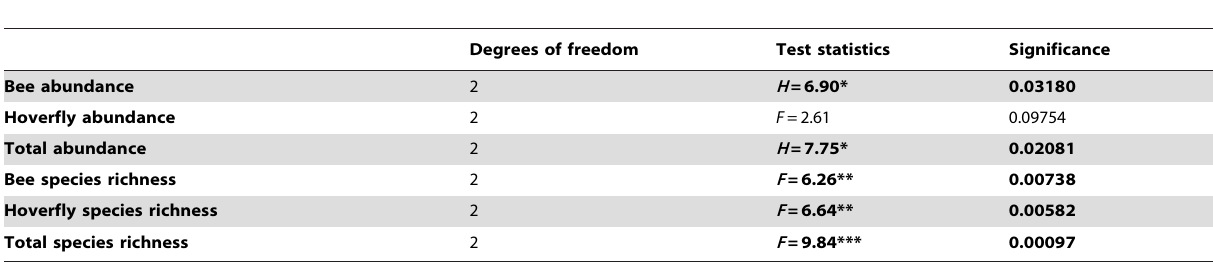
Table 1. Means tests for differences between Urban, Suburban, and Rural